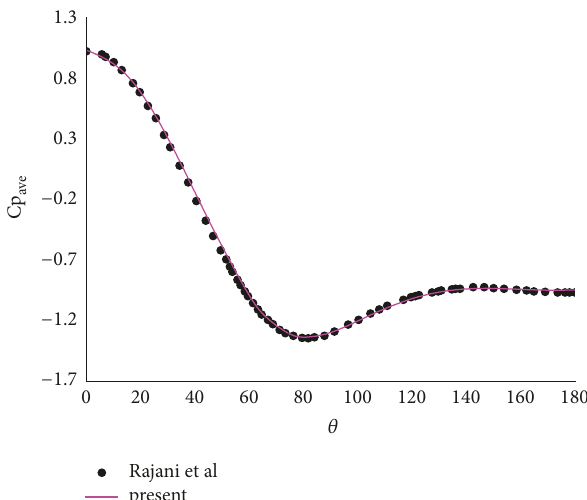
Figure 10: Distribution of time averaged pressure coefficients on the surface of circular cylinder.